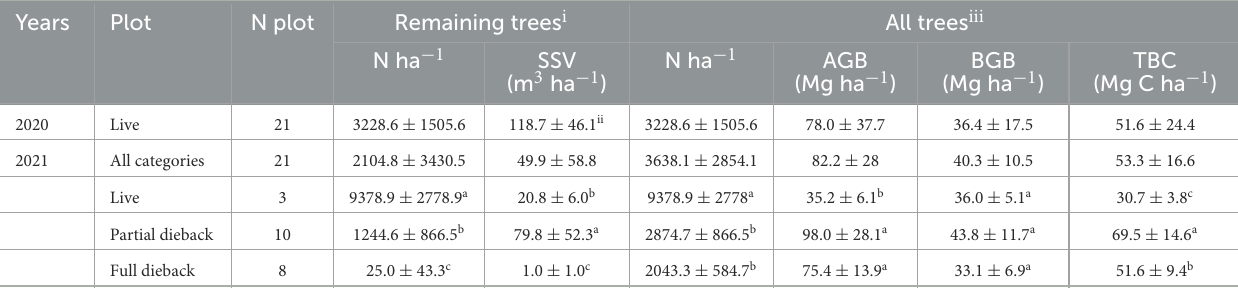
TABLE 3 Standing stock volume (SSV) and carbon stock estimation in mangrove stands in East Lampung during 2020–2021 (mean ± SD). Years Plot